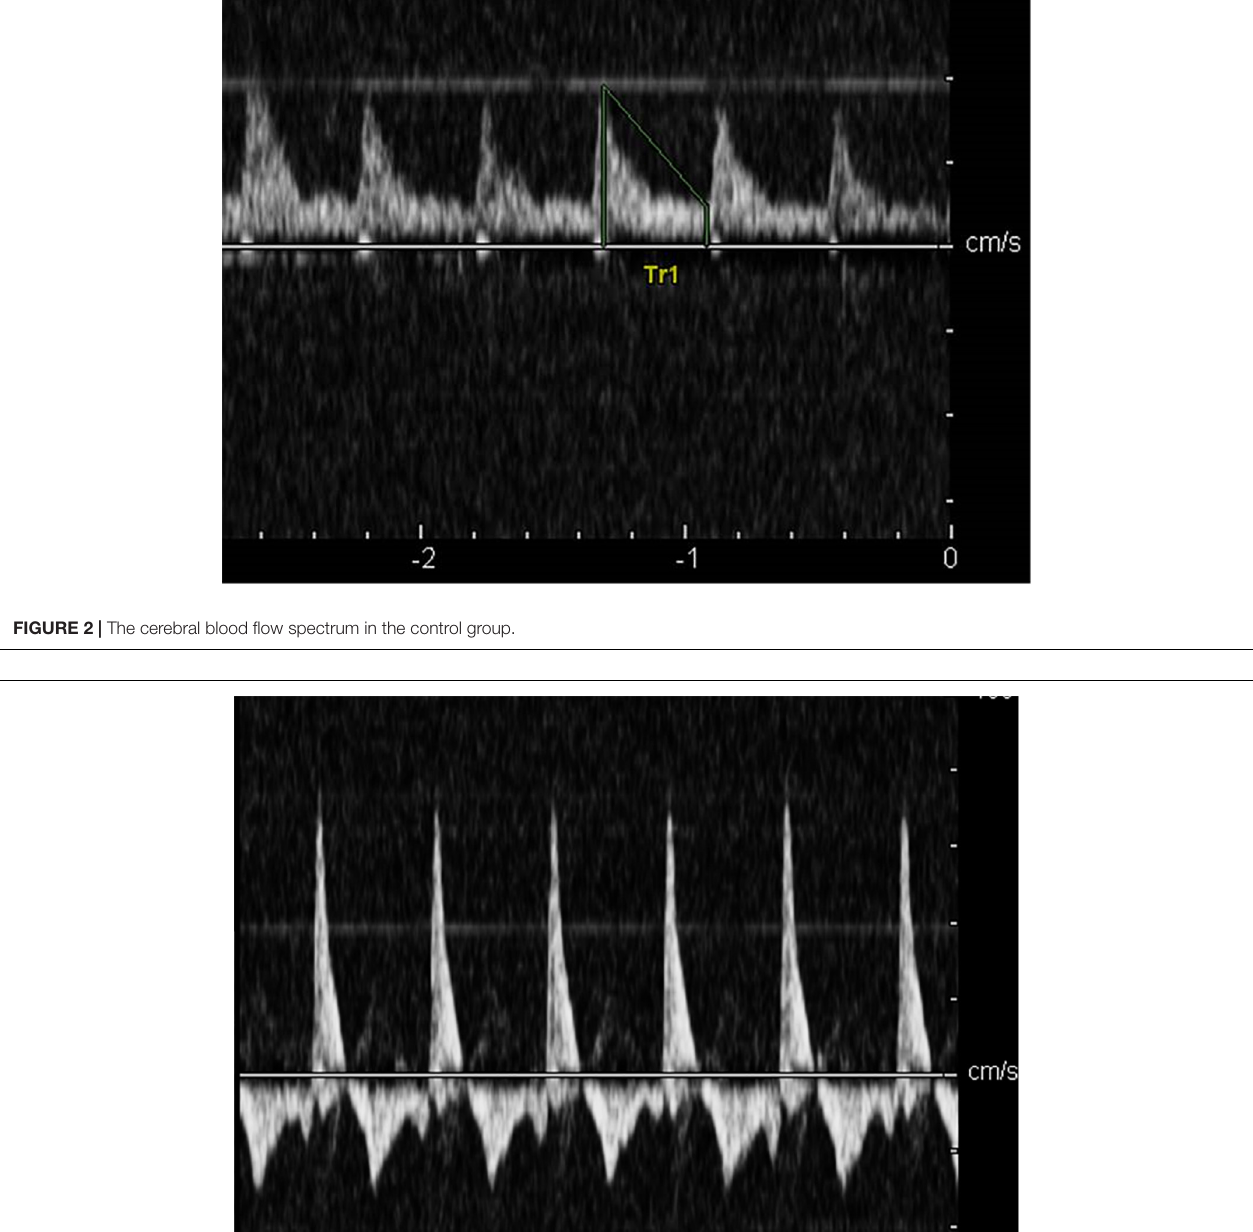
hypoxia of brain tissue, aggravation of brain edema, even cerebral circulation stop, resulting in clinical brain